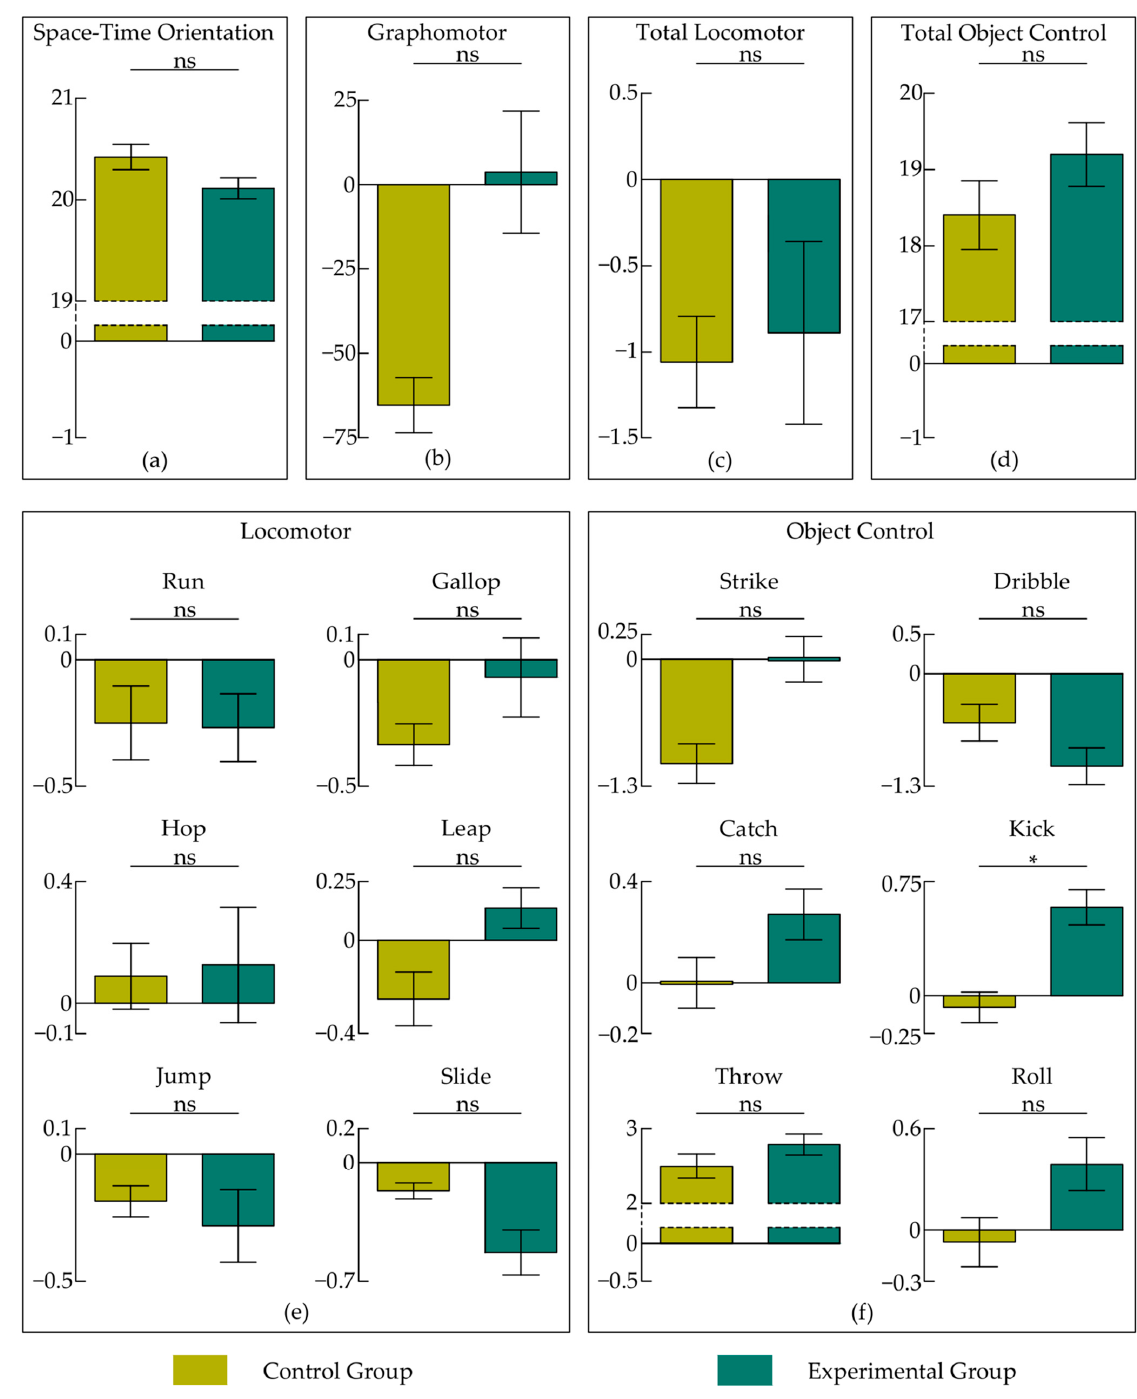
Figure 6. Motor progress in the control and experimental group was considered as changes ( ∆ ) between post-test and pre-test (baseline) scores or—if necessary—as estimated post-test scores. ( a ) Estimated differences between groups’ post-test scores in space-time orientation; ( b ) differences between groups’ ∆ in graphomotor skills; ( c ) differences between groups’ ∆ in total locomotor skills; ( d ) estimated differences between groups’ post-test scores in total object control skills; ( e ) differences between groups’ ∆ in particular locomotor skills, i.e., in running, galloping, hopping, leaping, jumping and sliding; ( f ) differences between groups’ ∆ in particular object control skills, i.e., in striking, dribbling, catching, kicking and rolling, and estimated differences between groups’ post-test scores in throwing. Asterisk (*) indicates significant p -values ( p < 0.05), and “ns” is not significant. Error bars depict standard errors of the